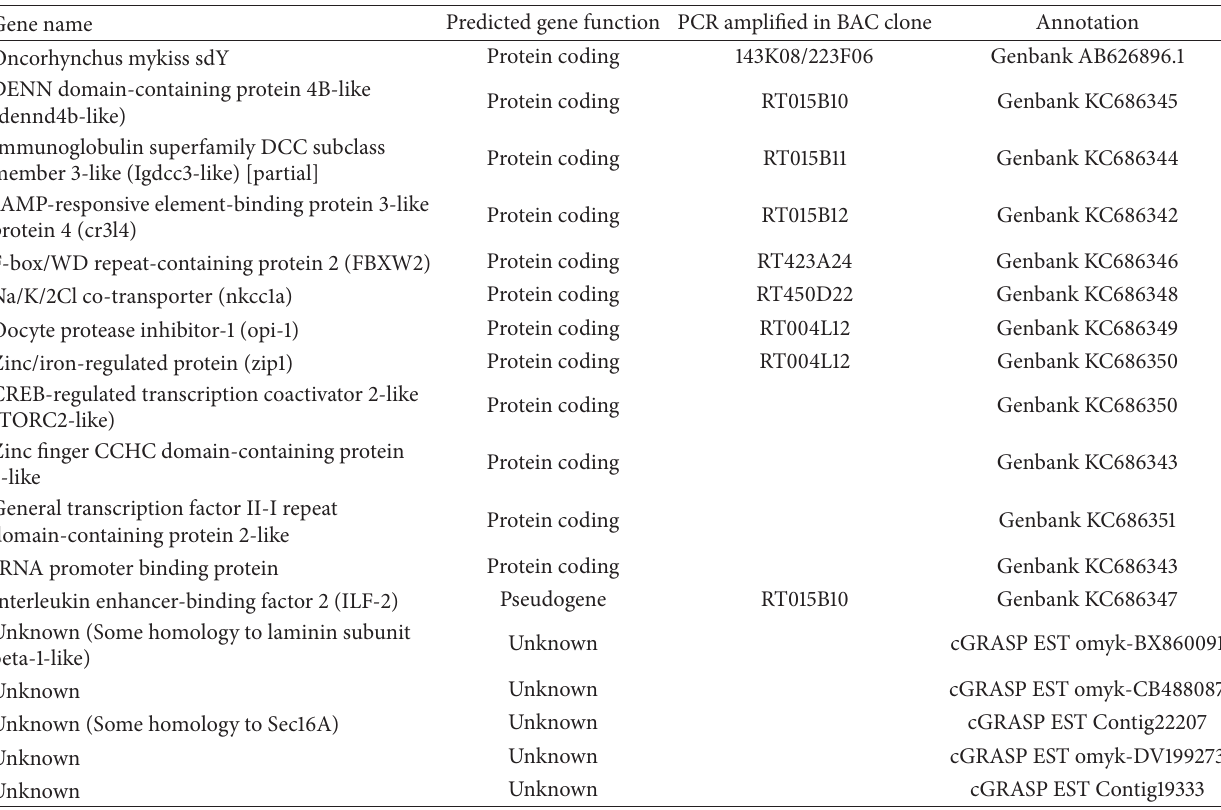
Table 1: List of predicted protein coding genes, pseudogenes, and unknown transcripts found in rainbow trout physical map contig #6256 sequence assemblies. Pseudogenes were differentiated from protein coding genes based on the presence of premature stop codons in open reading frames. The BAC clone column denotes the clone in the contig that gave a PCR product for the gene in